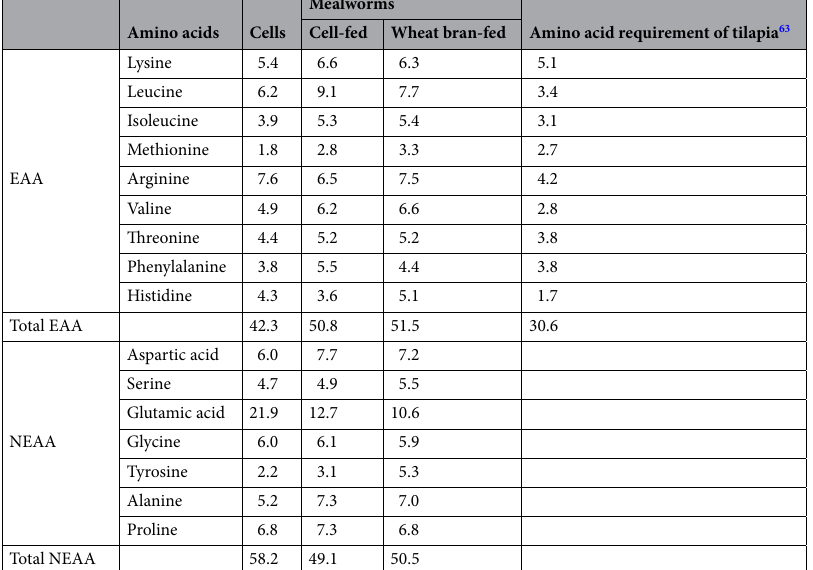
Table 3. Amino acid profile (g/100 g of protein) of bacterial cells, cell-fed, and wheat bran-fed mealworms. Values were based on a single analysis. EAA essential amino acids (tryptophan not determined), NEAA non- essential amino acids.